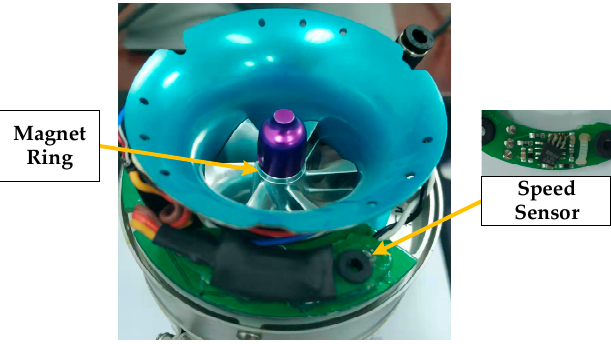
Figure 3. The installation of speed sensor KMZ10CM.